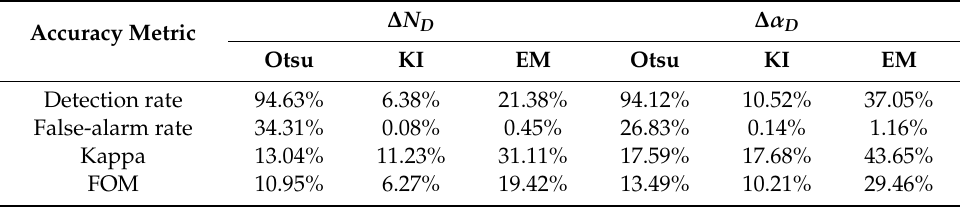
Table 1. Detection accuracies for the di ff erent polarimetric parameters.